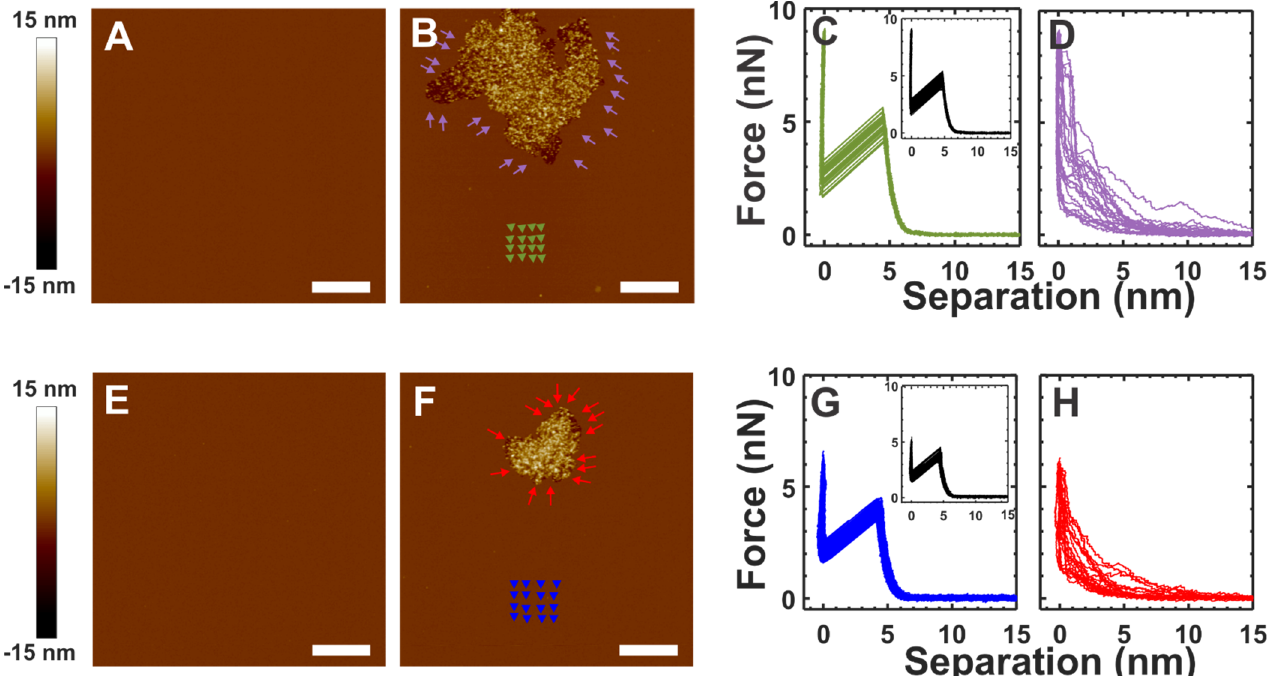
Figure 3. α -Crystallin interacting with the SLMs prepared with different buffers. The top and bottom rows correspond to images and force curves of the membrane prepared using buffer B with 5 mM CaCl 2 and 10 mM MgCl 2 , respectively, though ~5 mL of divalent salt-free buffer (buffer A) was used for flushing out unfused vesicles before imaging, as described previously [54]. ( A , E ) The SLM without α -crystallin. ( B , F ) α -Crystallin in buffer A incubated with SLM for ~40 min. ( C ) Force curves (green curves) were obtained for the membrane region around the green arrowheads in ( B ), while the inset force curves (black curves) were obtained for the control membrane shown in ( A ). ( D ) Force curves (purple curves) were obtained around the α -crystallin associated membrane region, as shown by the purple arrows in ( B ). ( G ) Force curves (blue curves) were obtained for the membrane region around the blue arrowheads in ( F ), while the inset force curves (black curves) were obtained in the control membrane shown in ( E ). ( H ) Force curves (red curves) were obtained around the α -crystallin associated membrane region, as shown by the red arrows in ( F ). The arrows/arrowheads in the membrane show the approximate representative positions of the force curves taken. The complete force curves of ( C , G ) are similar to those in the Figure 2C inset, while the complete force curves of ( D , H ) are similar to those in the Figure 2E inset. Image scale: 1 µ